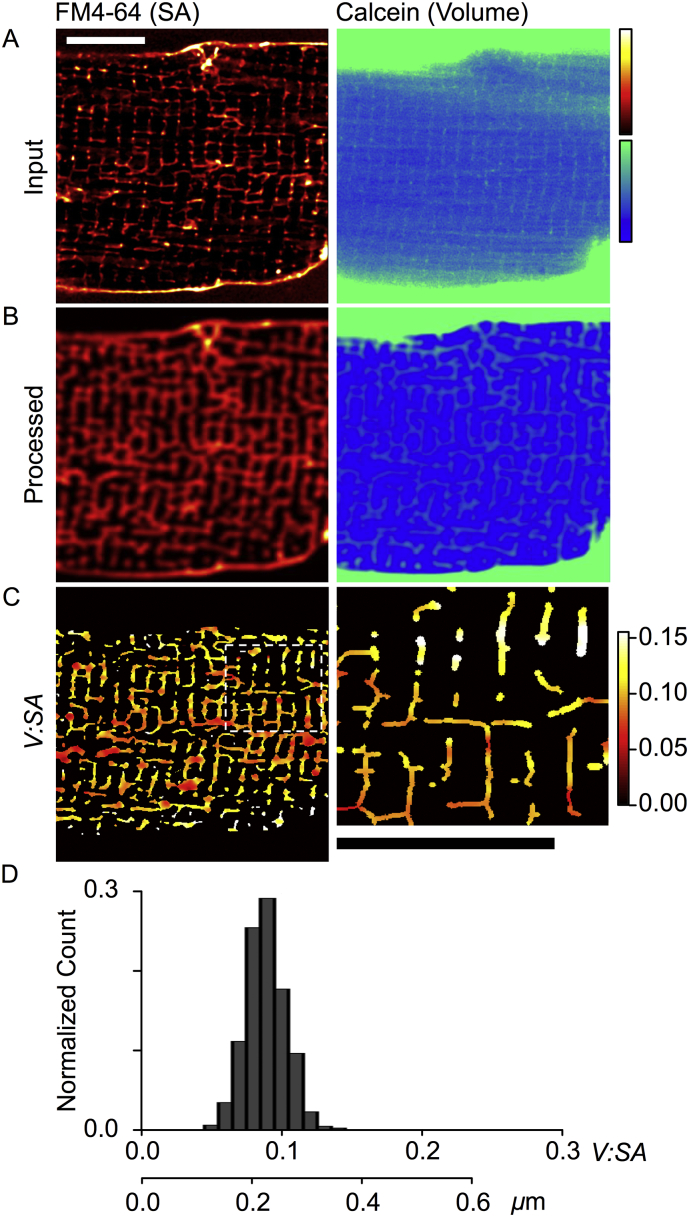
Application of the V:SA method to TTs in mouse ventricular myocytes. (A) Shows a region of a myocyte co-labeled with FM4-64 for the surface membranes (left panel), and calcein for the extracellular space and TT lumen (right panel). (B) Shows the same optical sections after image processing as described for Fig. 1B. (C) The left panel shows the V:SA values calculated for pixels within the intermediary TT mask. The right panel shows the region marked in C (dashed white box). Scale bars show 10 μm. (D) Shows histograms of V:SA values within the TT skeleton from the cell shown in A-C. The lower scale bar shows conversion from V:SA to TT diameter. Mean data is given in Table 1.